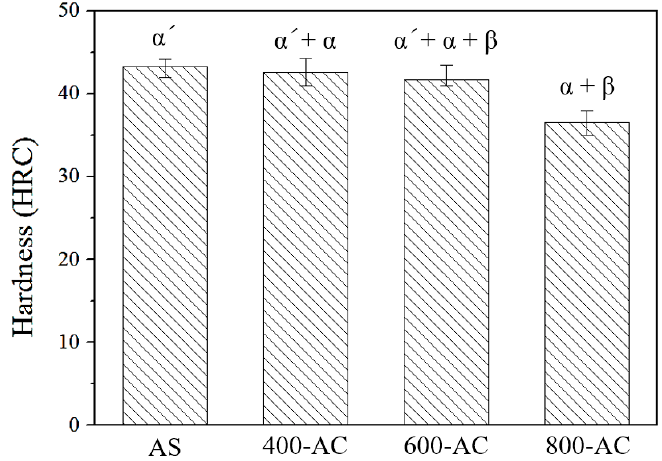
Figure 6. Hardness of AS, 400-AC, 600-AC, and 800-AC (normal direction).